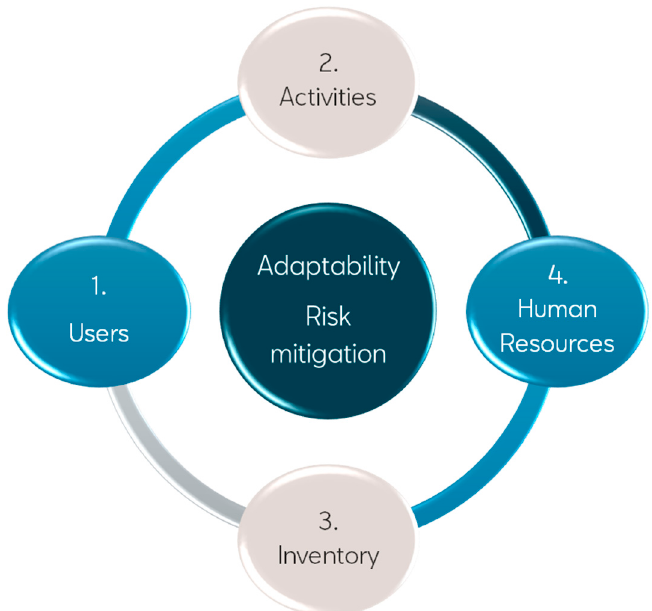
Figure 2. The 4-Elements-Model for adaptable self-protection plans (own elaboration) .